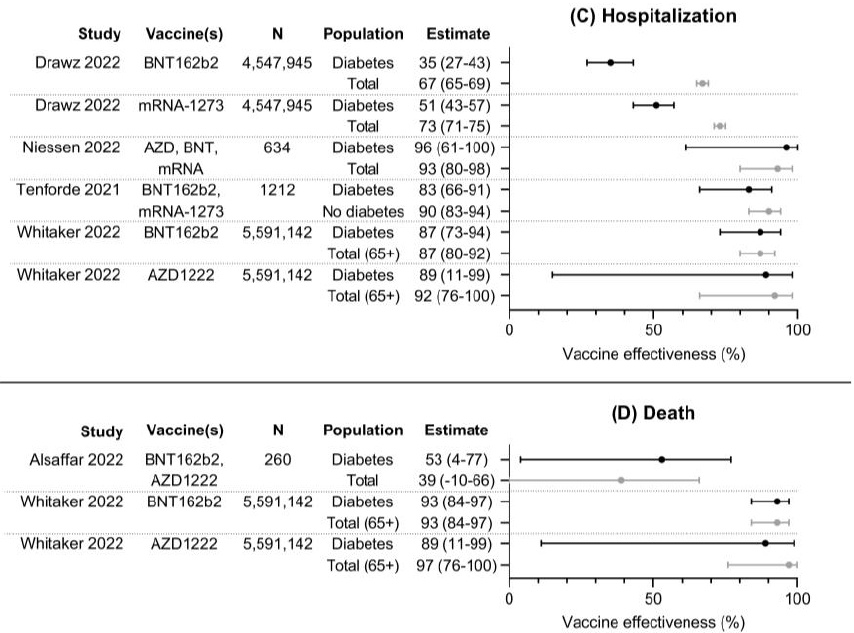
Figure 2. Forest plots with point estimates and 95% confidence intervals of effectiveness of COVID-19 vaccines against ( A ) infection, ( B ) symptomatic illness, ( C ) hospitalization, and ( D ) death. N denotes total number of participants per study, as numbers per group were usually not available [20,22,23,25–27,29,31–35].